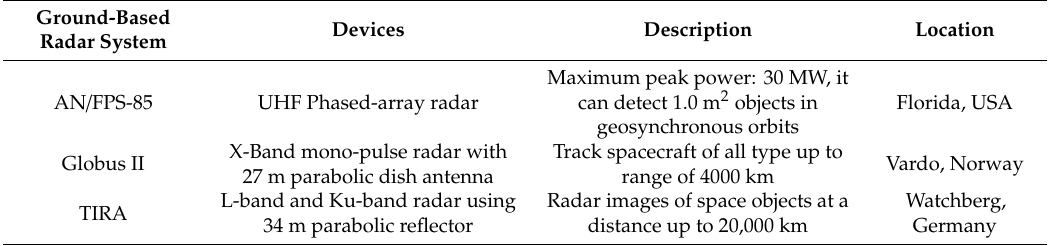
Table 1. Overview of Space Surveillance and Tracking (SST) ground-based radar systems {Choi, 2017